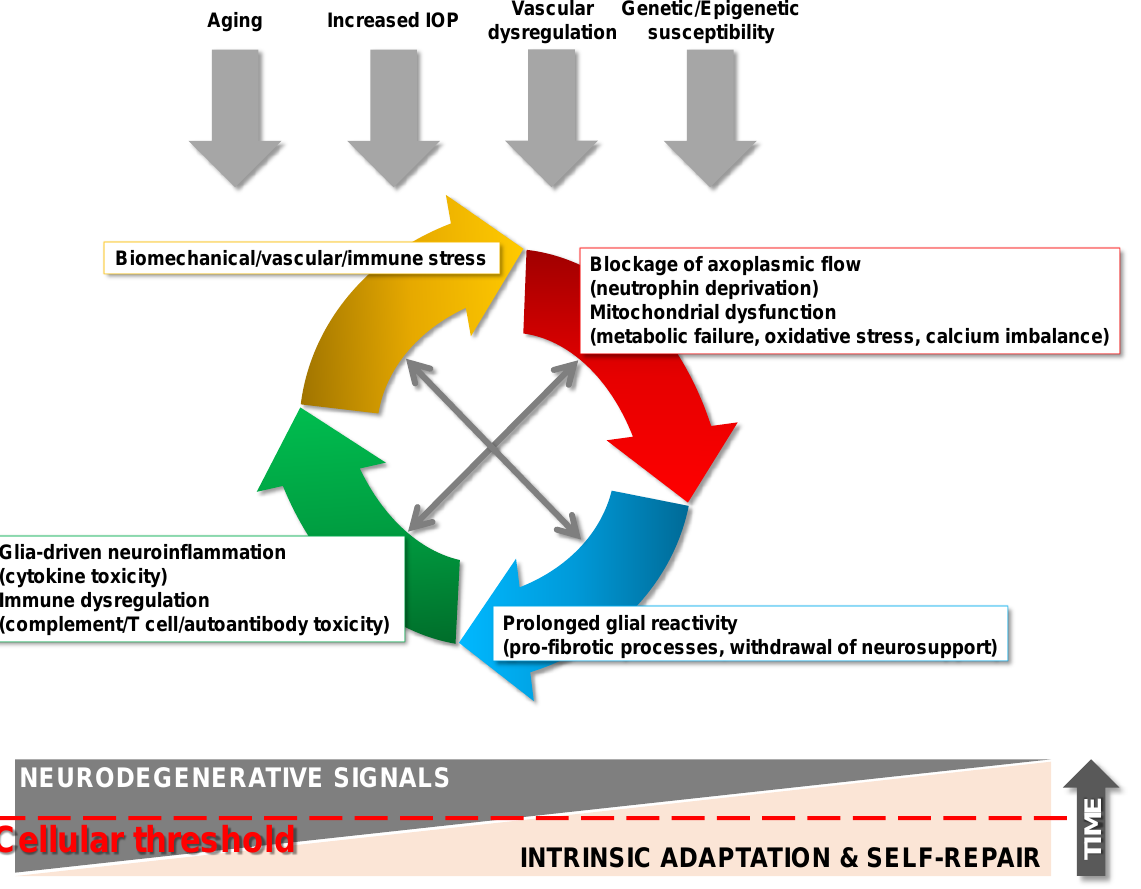
Figure 1. Glaucoma is a multifactorial neurodegenerative disease. The etiological framework of neurodegeneration in glaucoma encompasses multiple stressors, including increased intraocular pressure (IOP), aging, vascular dysfunction, and genetic/epigenetic factors. Interconnected pathogenic processes for glaucomatous neurodegeneration involves biomechanical, vascular, metabolic, oxidative, or inflammatory components. The asynchrony in RGC degeneration in glaucoma, along with the complexity of extrinsic triggers and intrinsic adaptive/reparative responses, suggest that a cellular stressor threshold determines the individual susceptibility of RGCs to injury in glaucoma.